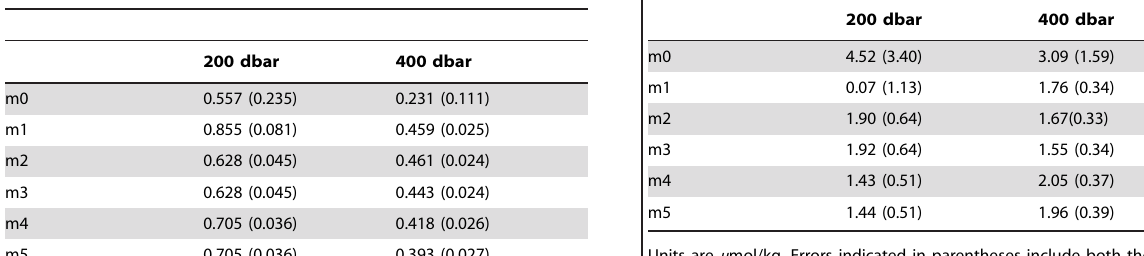
Figure 4. Projections based on the first four surveys. Blue circles indicate data from the first four surveys with environmental variability removed using the model indicated in the panel label. The regression lines have been fitted to these data. Magenta crosses indicate data from the most recent survey. Overlays in contrasting colors indicate the means of the filtered data for each of the five surveys.